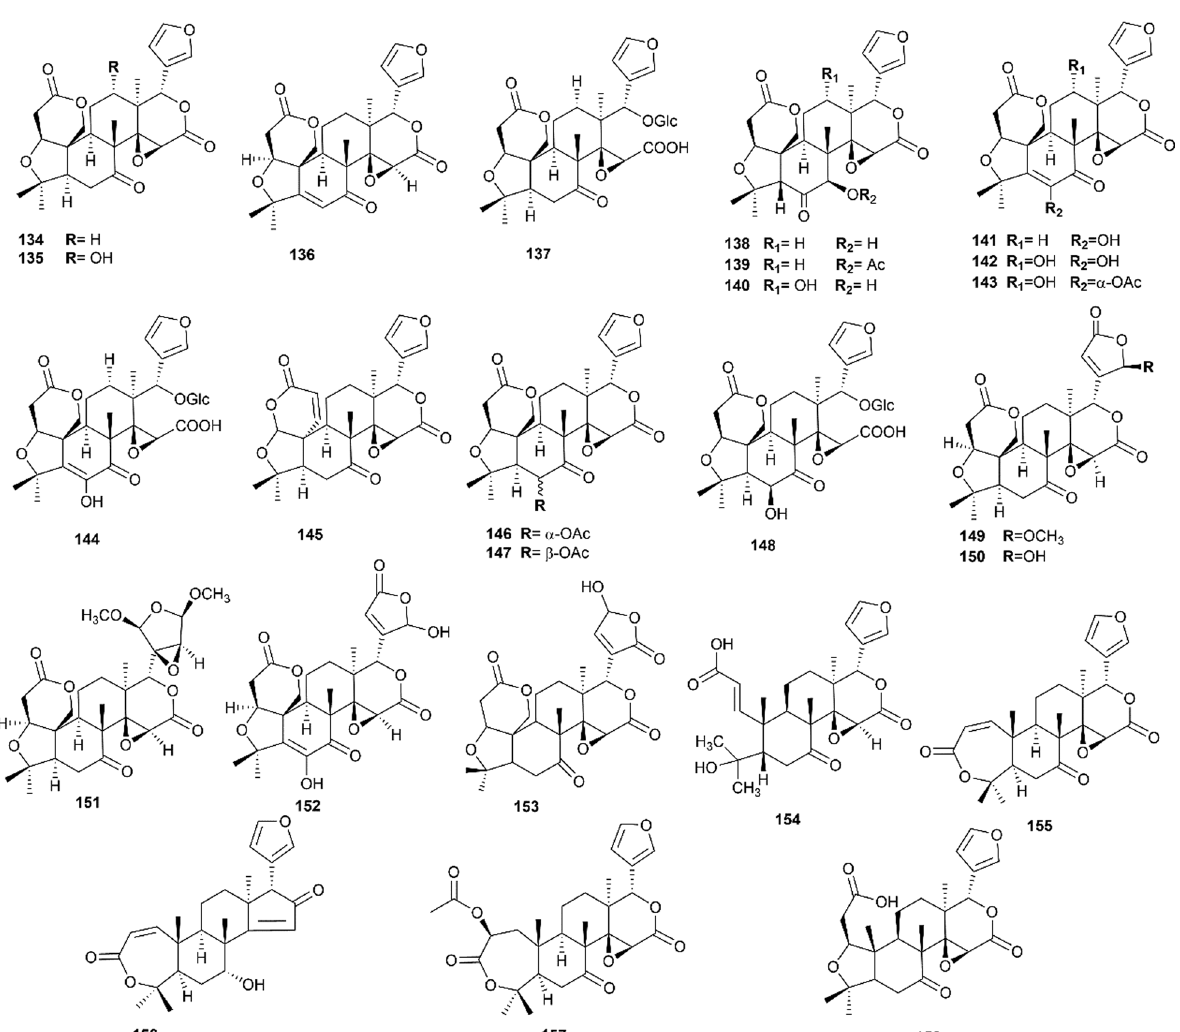
Fig. 5 Limonoids isolated from Euodiae